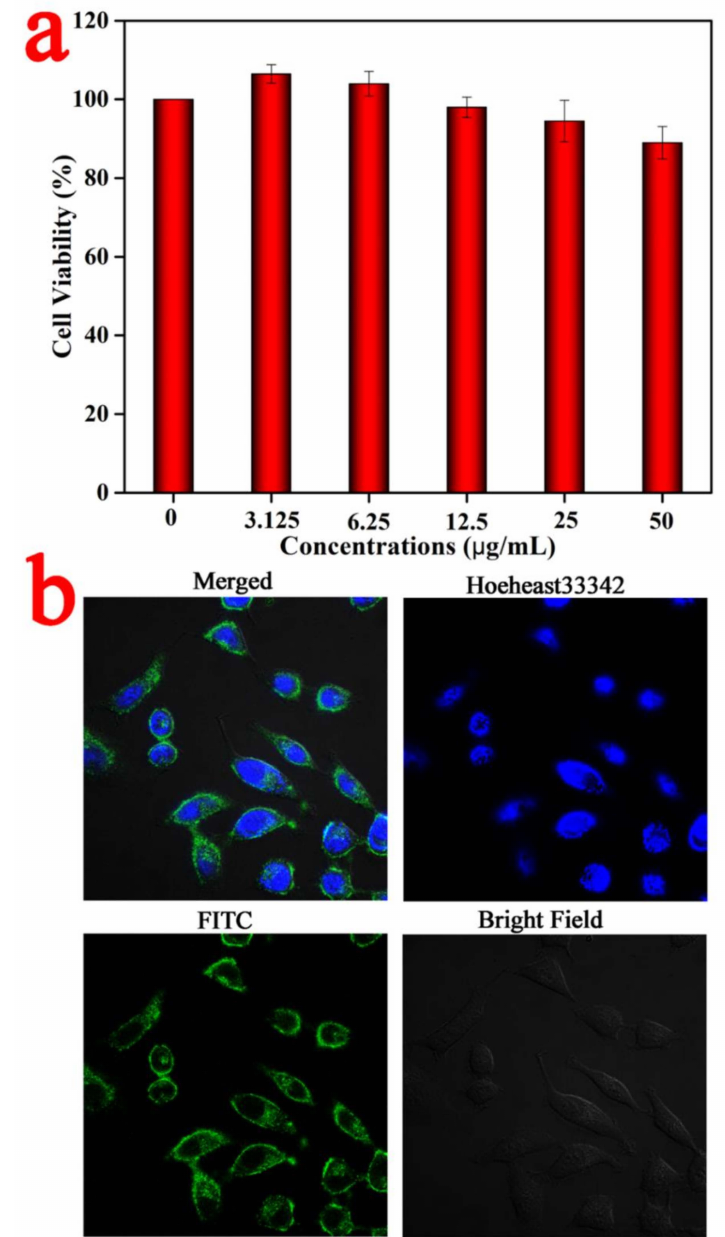
Figure 5. ( a ) The viabilities of HeLa cells after 24 h of incubation with different concentrations of UA. ( b ) Confocal laser scanning microscopic (CLSM) imaging of HeLa cells after co-incubation with UA–FITC (the nucleus was stained with Hoechst